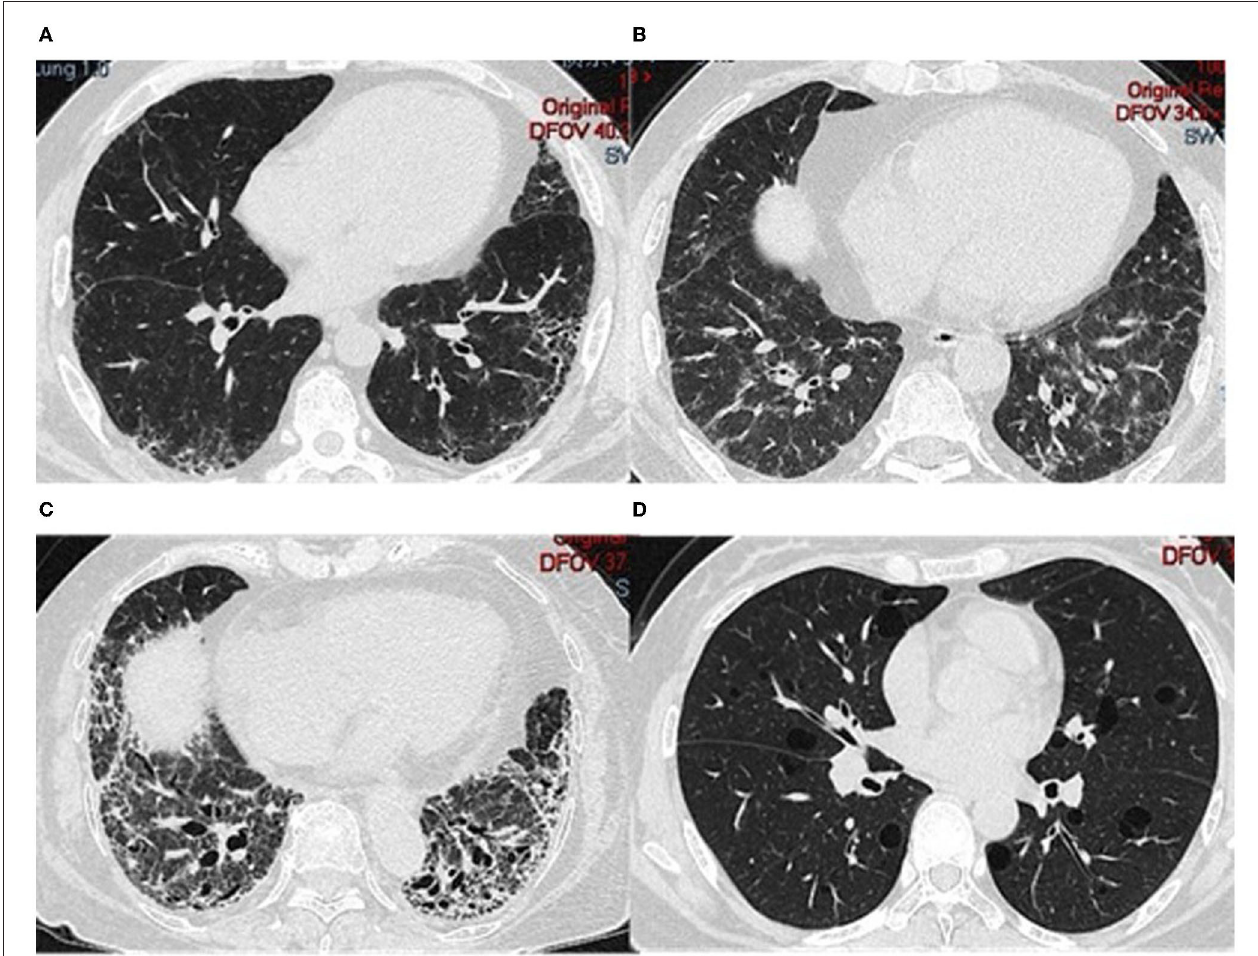
FIGURE 3 | HRCT from different patients who tested positive for anti-PM/Scl. (A) 41-year-old man; (B) 52-year-old man; (C) 83-year-old woman; (D) 41-year-old